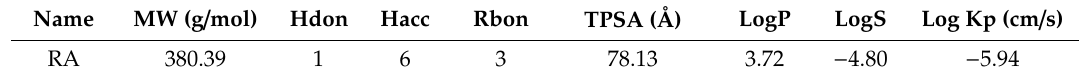
Figure 1. ( a ) The Chemical structure of RA; ( b ) The binding mode of RA with the DNA-Topo I complex (PDB:1T8I). Table 1. Pharmacological and molecular properties of RA.